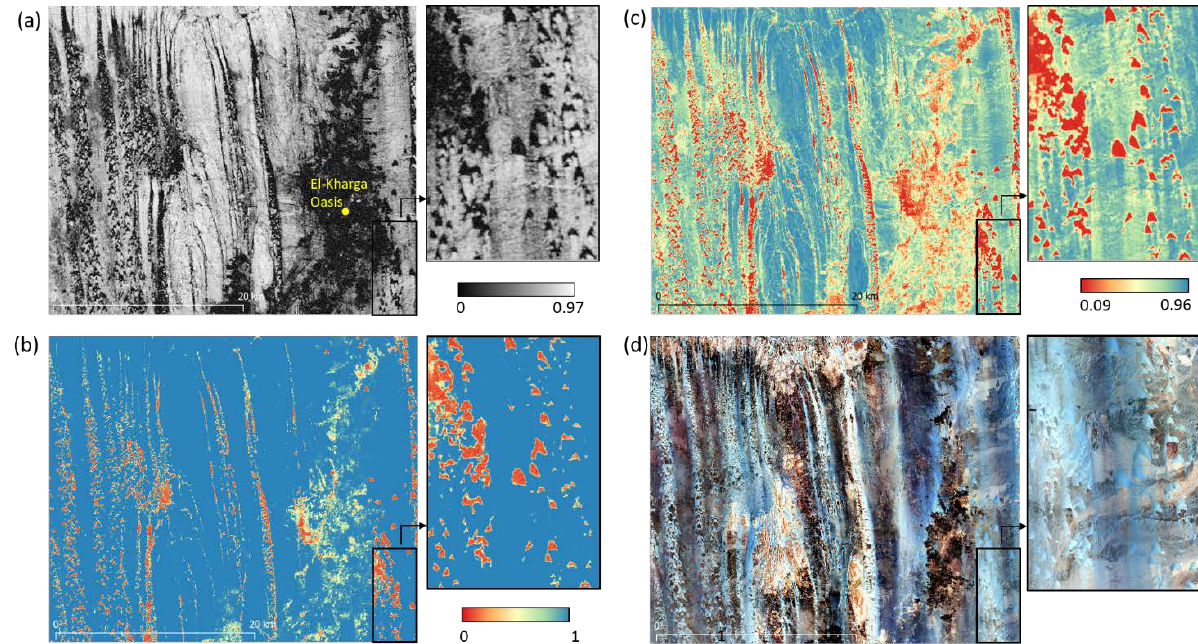
Figure 6. Egypt use case: (a) coherence absolute values computed between the two images at the longest temporal baseline; (b) Temporal Stability Index; (c) mean of short-term coherence (MSTC); (d) Sentinel-2 optical image after an adaptive histogram equalization which enhances sand visualization (light blue